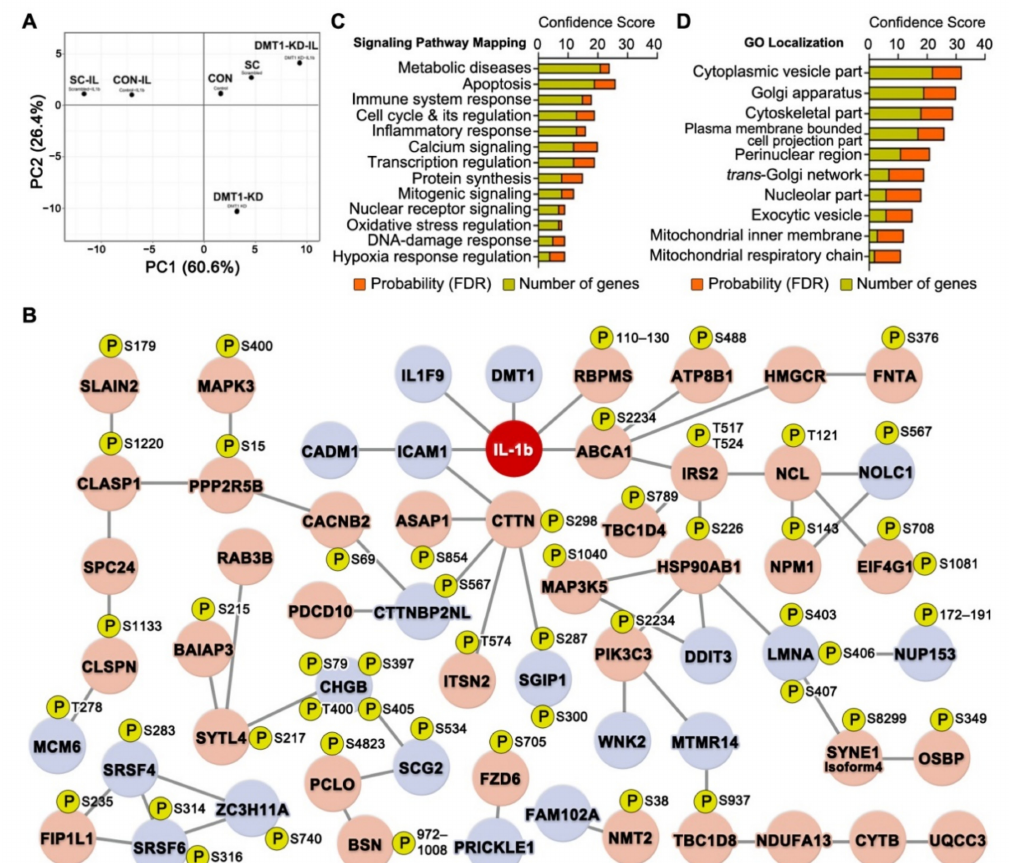
Figure 5. Replenishment of potential protective proteins and protein phosphorylation in IL-1 β exposed DMT1 knock- down β -cells. ( A ) PCA plots of the proteome and phosphoproteome profiles of Control (CON), Scrambled (SC), DMT1 KD ( DMT1 -KD), Control + IL-1 β (CON-IL), Scrambled + IL-1b (SI), DMT1 KD + IL-1 β ( DMT1 -KD-IL) cells. ( B ) β -cell inflammation-protective proteins interaction network (PPIN) among potential protective proteins and/or phosphorylation in IL-1 β exposed DMT1 depletion β -cells. Red node: significantly increased levels in both SC/SI and DMT1 -KD-IL/SI. Blue node: significantly decreased levels in both SC/SI and DMT1 -KD-IL/SI. P: phosphosite. ( C ) Mapping of signaling pathways of potential protective proteins and/or phosphorylation formed prominent in order by confidence score (sum of FDR and genes). ( D ) Gene Ontology subcellular localization of potential protective proteins and/or phosphorylation formed prominent in order by confidence score (sum of FDR and